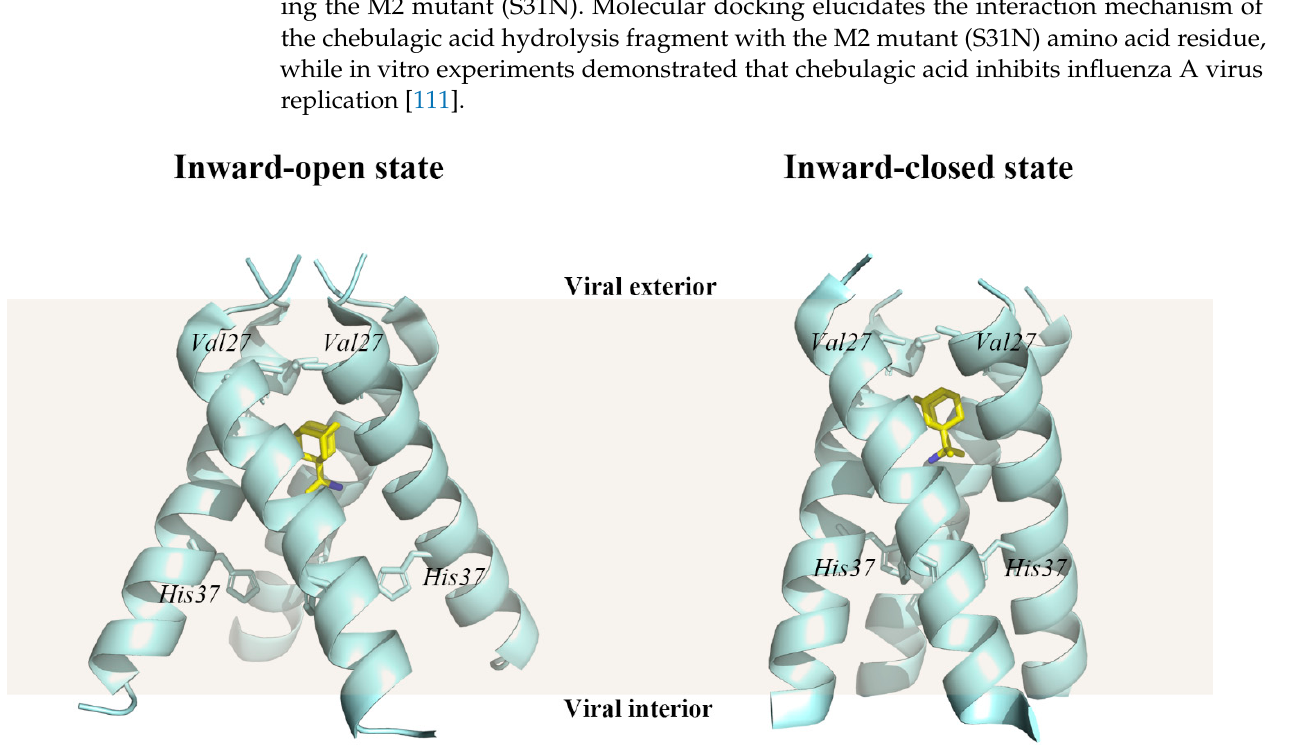
Figure 6. Structures of the influenza A virus M2 protein channel in complex with rimantadine. The transmembrane (TM) structural domain of M2 bound to rimantadine in the inward-open state (PDB ID: 6BOC) and in the inward-closed state (PDB ID: 6BKL) [107]. Wheat shade represents the viral membrane. The protein structure was displayed and analyzed through the PyMOL visualization program [69–71].